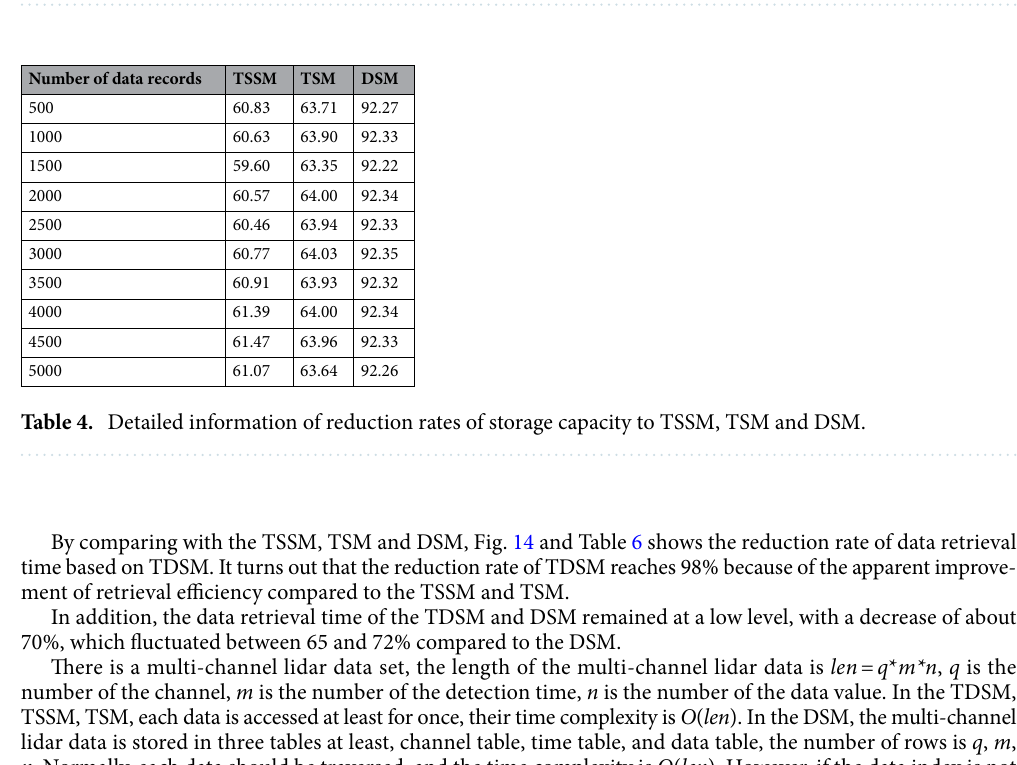
Figure 12. The reduction rate of storage capacity of TSSM, TSM and DSM.